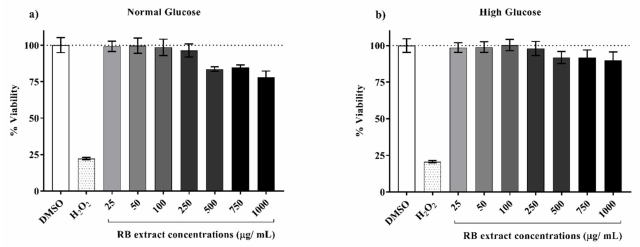
Figure 1. INS-1E cell viability 6 h post-exposure to various concentrations of RB phenolic extracts. ( a ) Normal glucose conditions, ( b ) High glucose conditions ( n = 8). Data are presented as Mean ± SD. Dimethyl sulfoxide, DMSO; Hydrogen Peroxide, H 2 O 2 ; Insulin-secreting rat insulinoma cell, INS-1E; Rice bran,